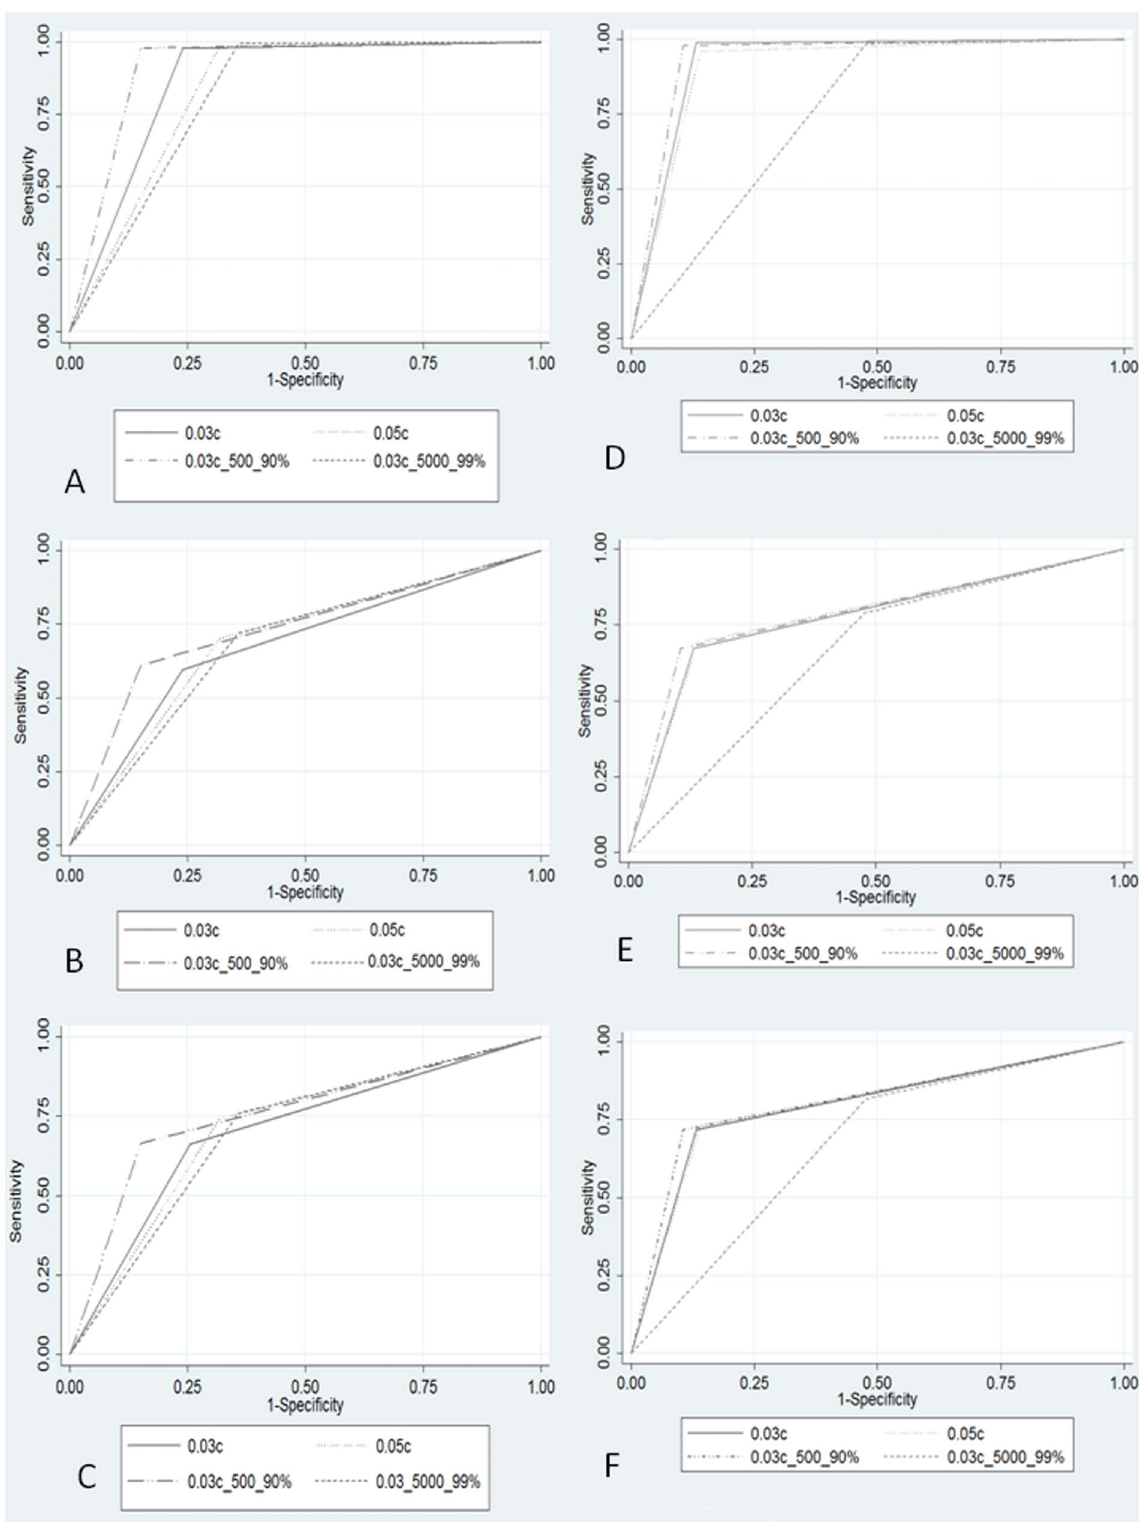
Figure 1. Comparative graphical illustration of the AUC for all classifications by study design (normal-abnormal) - Trial 1 (A) and Trial 2 (D); Comparative graphical illustration of the AUC for easy classifications (normal versus severely abnormal) by study design- Trial 1 (B) and Trial 2 (E); Comparative graphical illustration of the AUC for difficult classifications (normal versus mildly abnormal) by study design- Trial 1 (C) and Trial 2 (F).